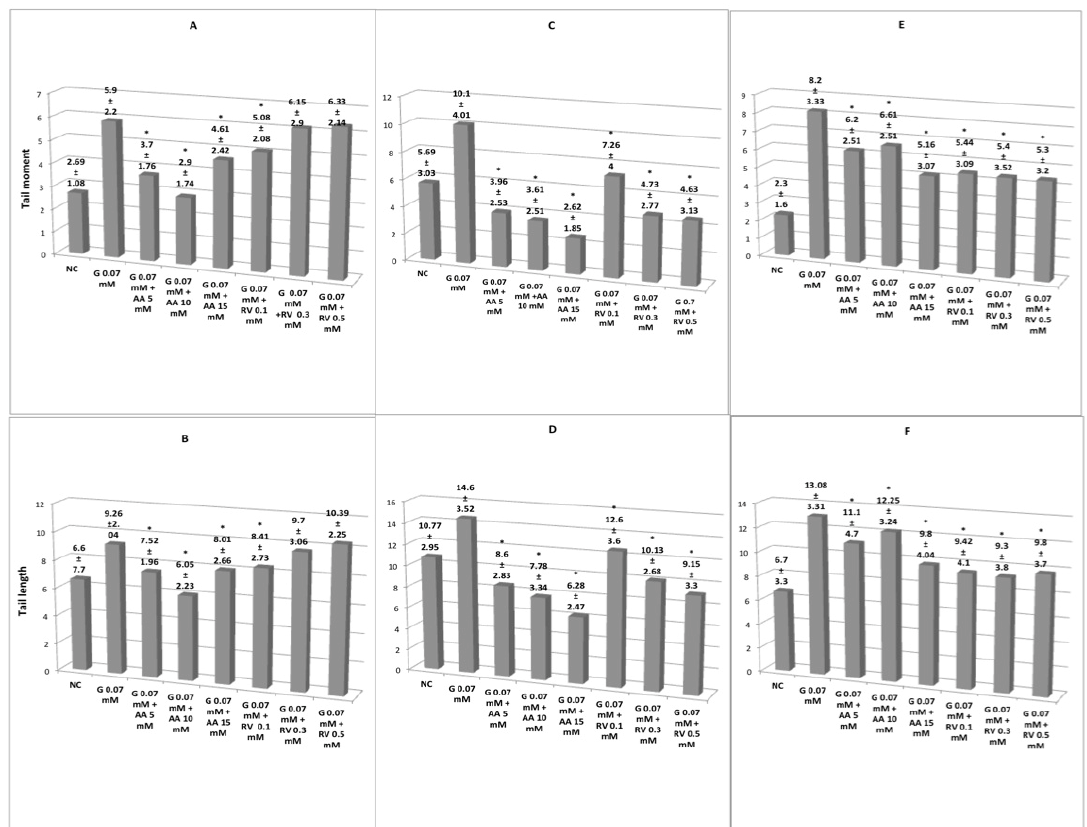
Figure 2. Tail moment and tail length in erythrocytes of Oreochromis niloticus ( A , B ) and Ambystoma mexicanum ( C , D ) and human lymphocytes ( E , F ) exposed to glyphosate 0.07 mM after exposure to ascorbic acid (AA) or resveratrol (RV). NC, negative control; PC, positive control. In ( C – F ) G-AA and G-RV concentrations in the three organisms studied were significantly different from G 0.07 mM ( p < 0.05). In ( A , B ), the three concentrations of G-AA were significantly different from G 0.07 mM. In ( A , B ), only the concentration G-0.07 mM—RV 0.1 mM was significantly different from G-0.07 mM. * Significant difference ( p < 0.05) with respect to G 0.07. Glyphosate